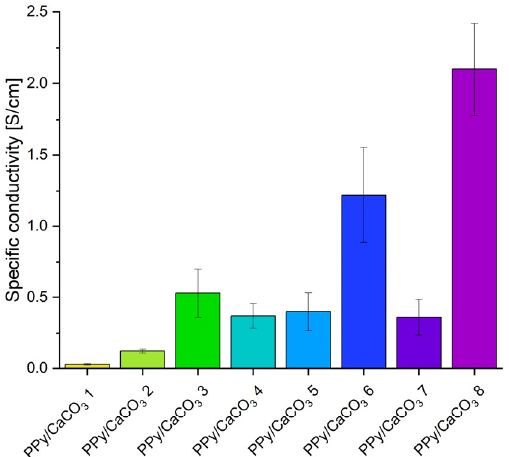
Figure 3. Overview of the specific conductivities of all PPy/CaCO 3 materials (PPy/CaCO 3 M1-M8) which are explained in detail in Table 1.